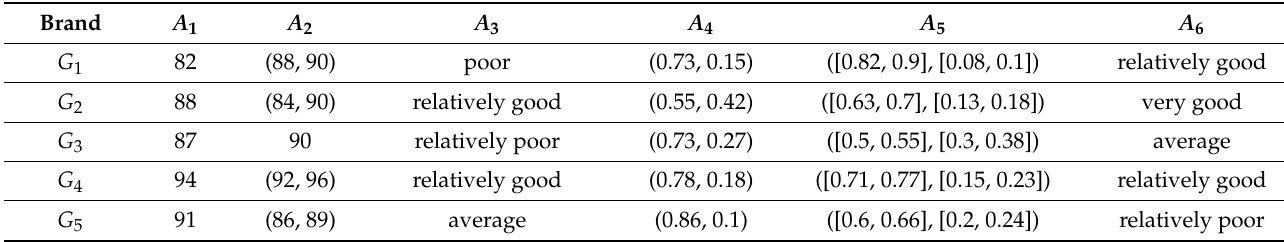
Table 6. The evaluation matrix of expert D 4 .